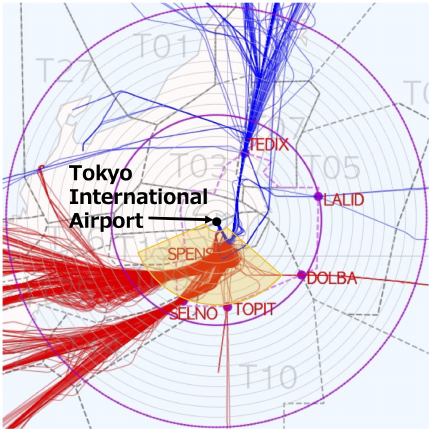
Figure 3. Terminal airspace (the orange